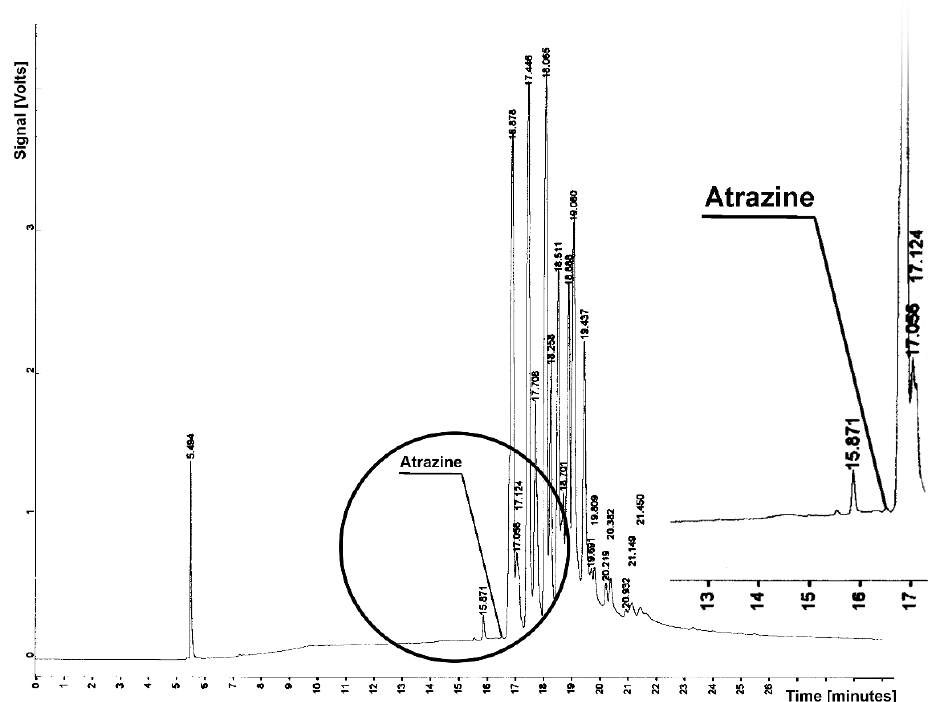
Figure 1. Chromatogram from determination of atrazine residue in sample from soil extraction; tR = 16.576—atrazine .